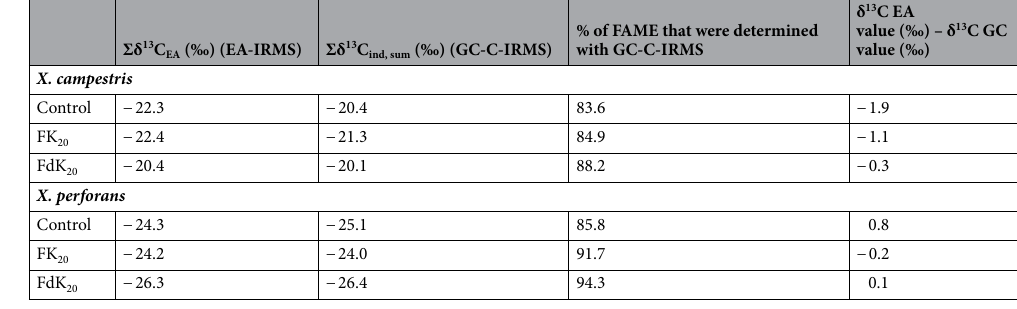
Table 3. Bulk δ 13 C values (‰) of X. campestris and X. perforans measured with EA-IRMS and calculated after GC-C-IRMS measurements of the individual